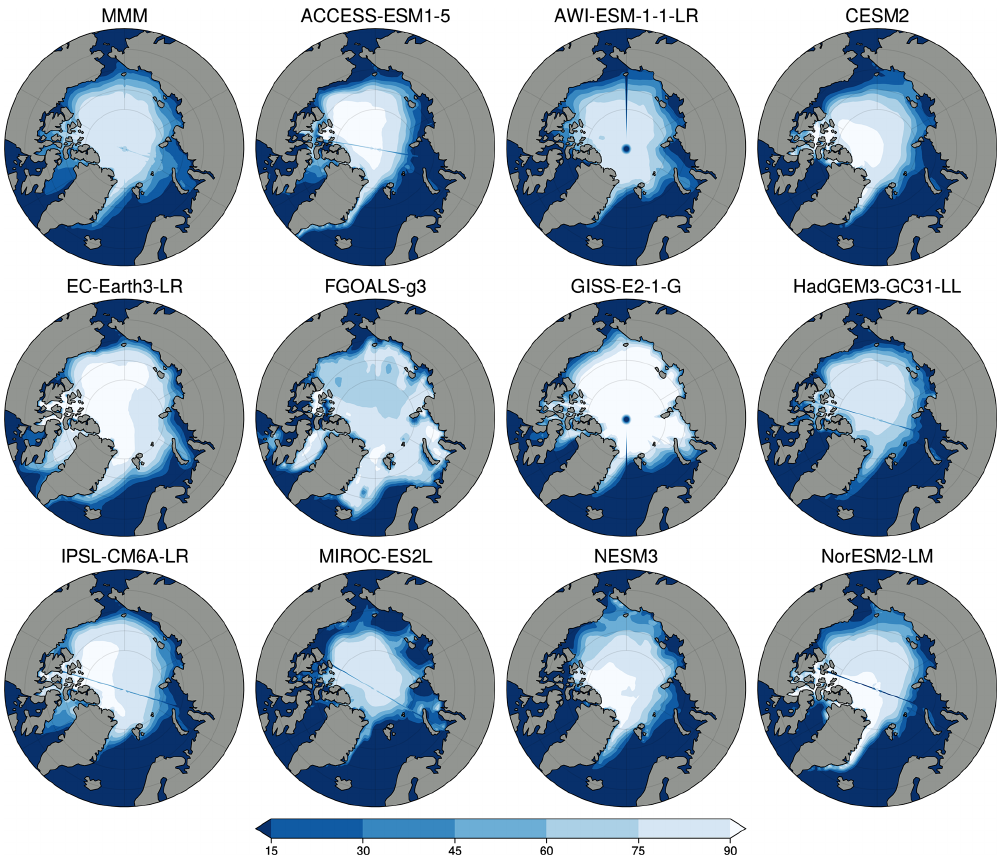
Figure 2. Climatological minimum PI sea ice concentration maps for each model. The first panel represents the multi-model mean